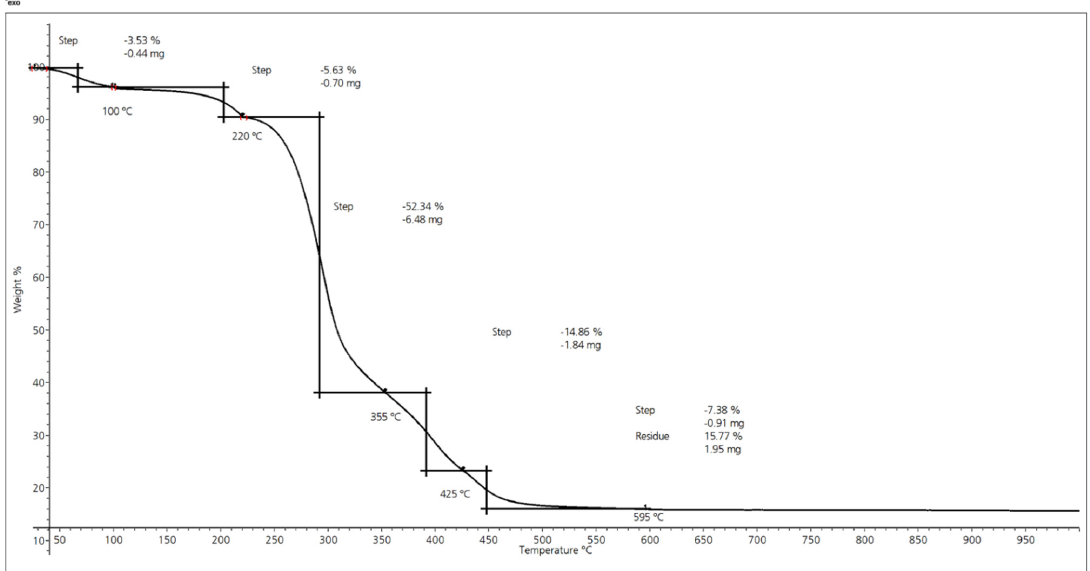
Figure 16. Thermal degradation steps for wheat straw particles.